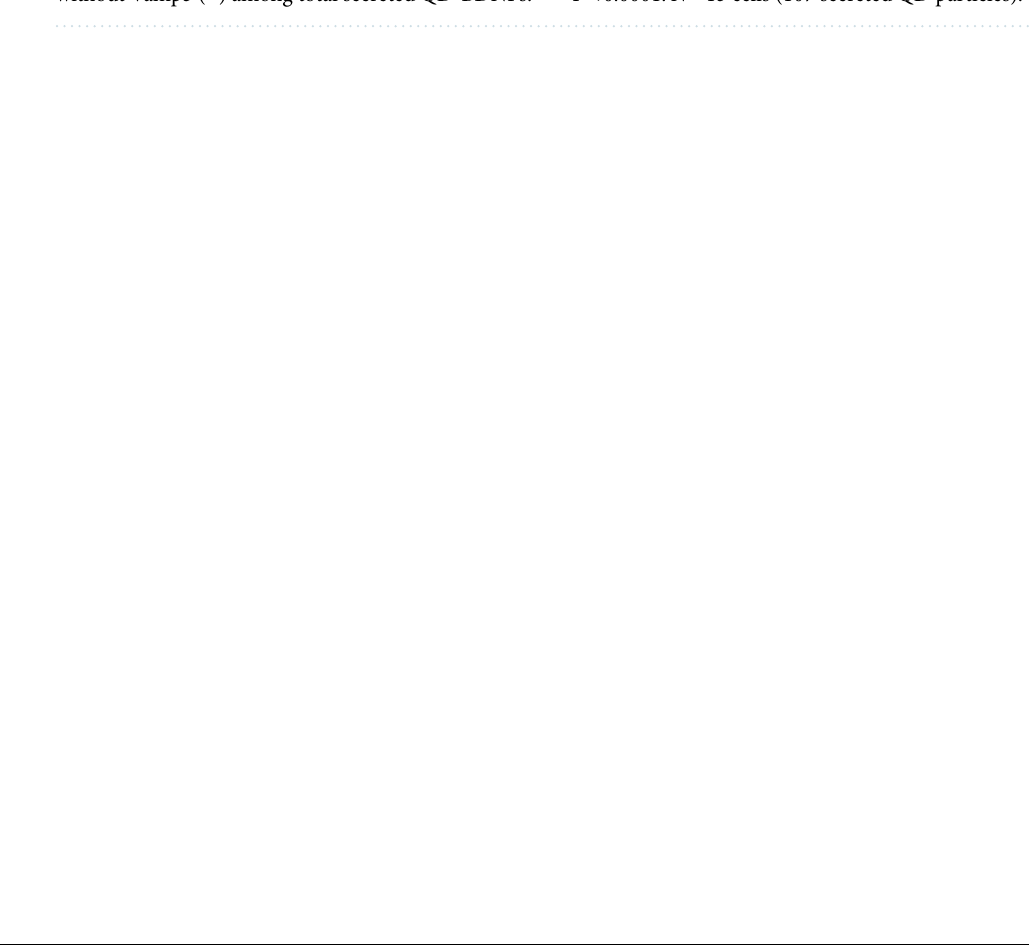
Figure 4. ATP-induced secretion of endocytic BDNF from Vamp3-containing vesicles. (A) Representative fluorescence images of astrocytic processes containing QD-BDNF and Vamp3-EGFP. The kymograph was generated by using ImageJ/FIJI software (Ver. 2.1.0/1.53c, NIH). Black arrow heads: Vamp3-positive QD-BDNF particles. Empty arrowheads: Vamp3-negative QD-BDNF particles. Red bar: ATP treatment. White sharp arrowheads: disappearance of QD-BDNF particles. Black bar = 30 s. ( B) Average percentages of ATP-induced QD-BDNF secretion events from vesicles with ( +) or without Vamp3 (−). ** P < 0.01, *** P < 0.001. N = 15 cells (vehicle = 162; ATP = 333 QD particles). ( C) Average fractions of secreted QD-BDNF particles with ( +) or without Vamp3 (−) among total secreted QD-BDNFs. **** P < 0.0001. N = 15 cells (107 secreted QD